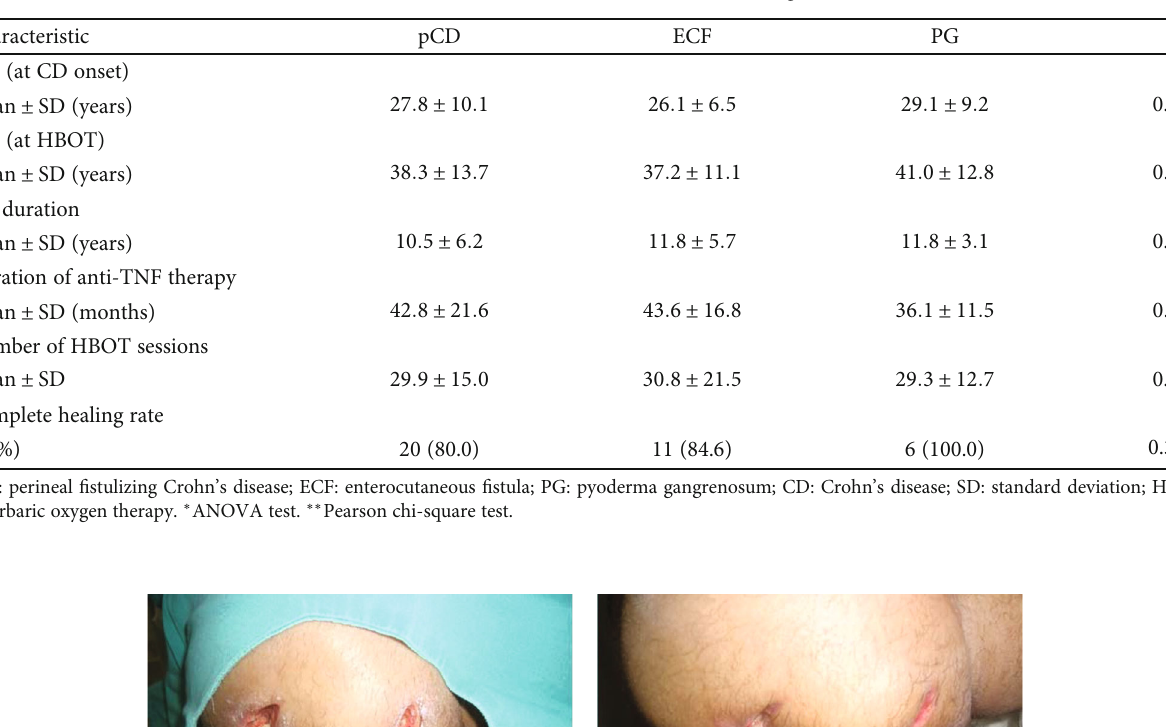
Table 2: Patients ’ characteristics and HBOT e ff ect according to indication.